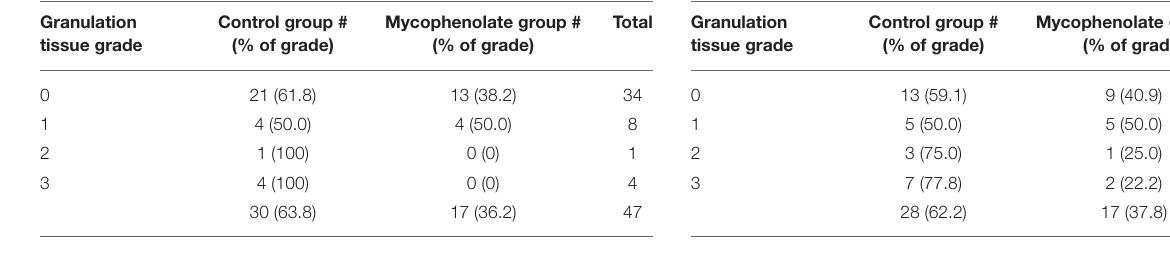
TABLE 5 | Presence and severity of granulation tissue at 3 month ± 2 week time point. Granulation tissue grade